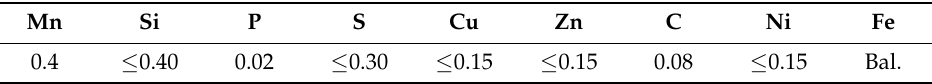
Table 1. Chemical compositions of ST04Z galvanized steel (wt. %).